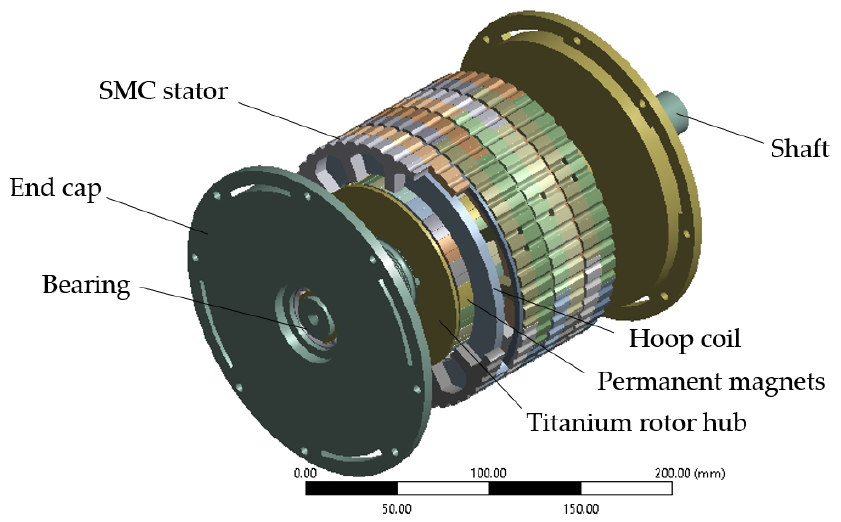
Figure 1. 3D view of a modular transverse flux machine assembly—145 components.